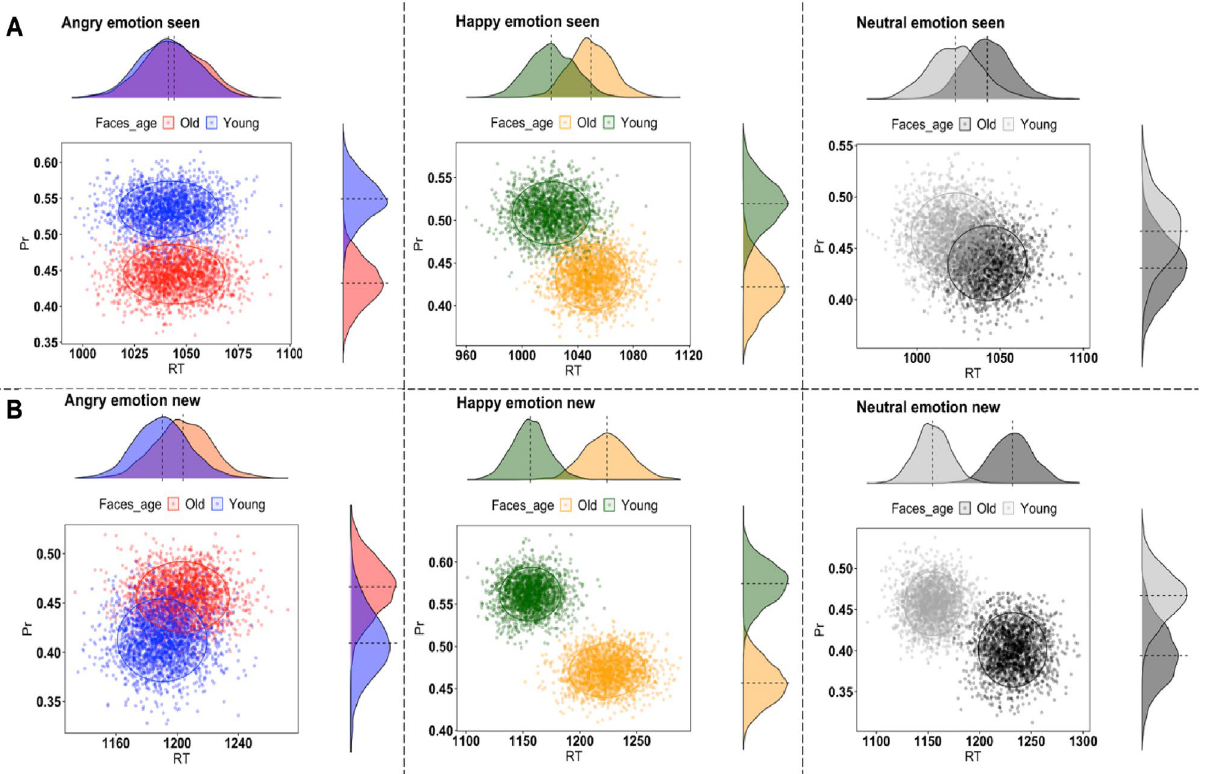
Figure 1. Bootstrapped means of RT (X-axis) and accuracy (Y-axis) for seen ( A ) and novel faces ( B ) in the test phase for Angry (left column), Happy (middle column) and Neutral faces of old and young individuals. Corresponding density plots visualize the distributional overlap of the effects for RT (top plots) and